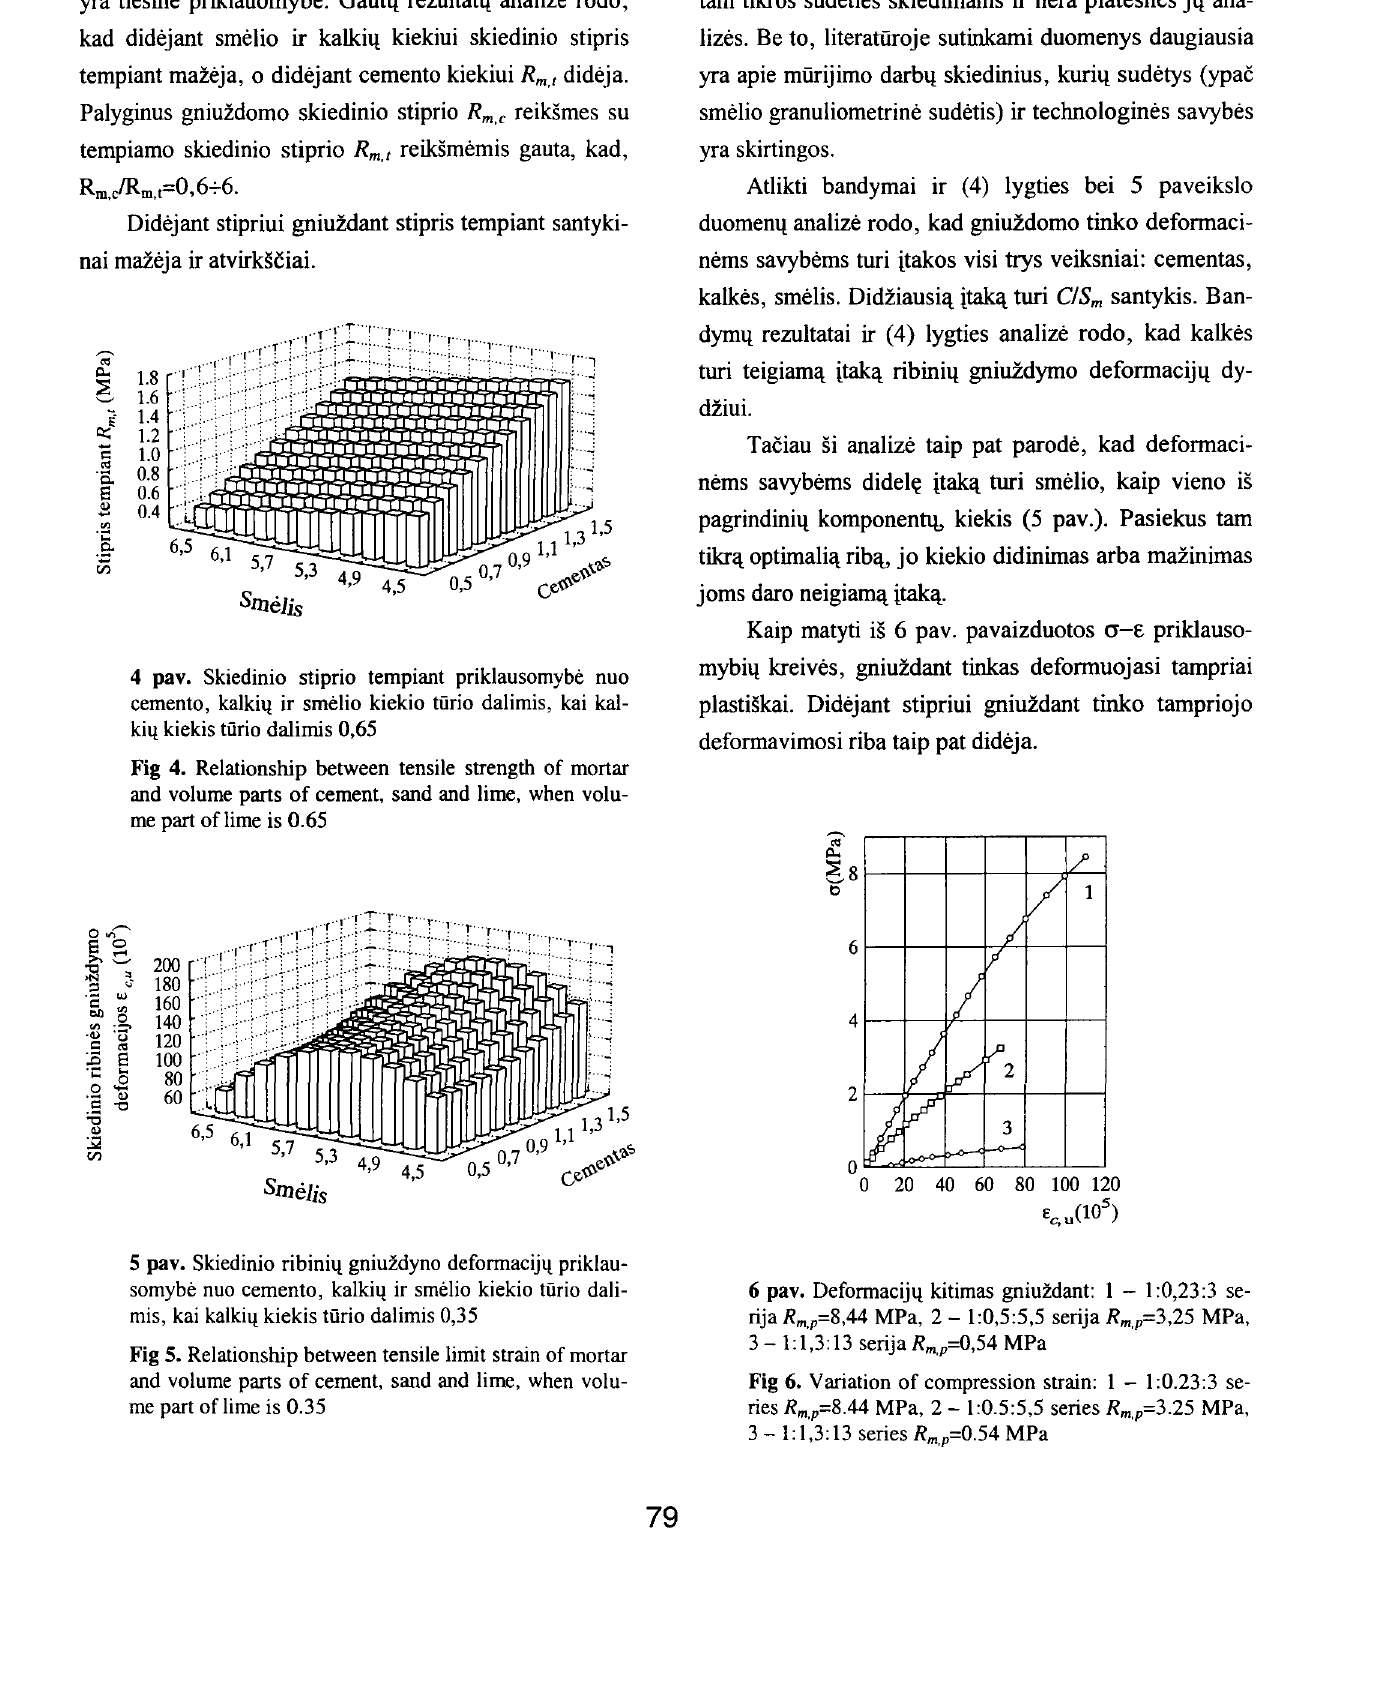
5 pav. Skiedinio ribinill gniuzdyno deformacijll priklau somybe nuo cemento, kalkill ir smi:lio kiekio tiirio dali mis, kai kalkill kiekis tiirio dalimis 0,35 Fig 5. Relationship between tensile limit strain of mortar and volume parts of cement, sand and lime, when volu me part of lime is 0.35